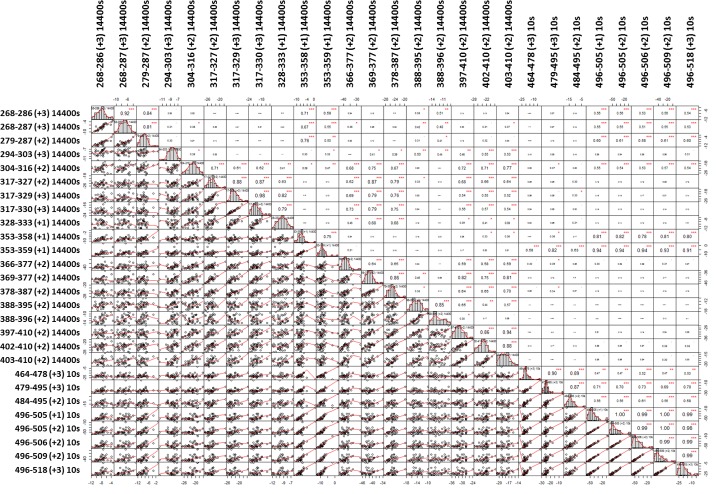
A weighted correlation analysis of the two timepoint compound screening dataset shows widespread correlation between peptides.Across the diagonal are histograms showing normal distributions of Δ%D for each peptide. Below the diagonal are correlation plots comparing peptide perturbation values of the peptides above and on the left of the corresponding plot. Above the diagonal are correlation coefficients (pearson’s R value) of a linear model describing the variances of peptide perturbation values of the peptides below and left of the corresponding R value. Significance is indicated for adjusted P vales <0.1, 0.05, 0.01 and 0.001 as. , *,**, and *** respectively.